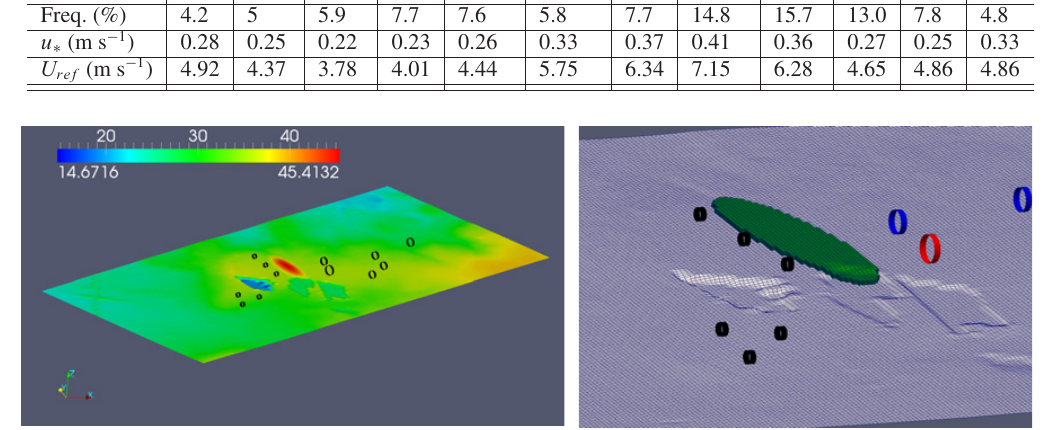
Table 1. Wind profile frequency (%), and constants u ∗ (m s − 1 ) and U ref (m s − 1 ), for each wind direction. E Freq. (%)